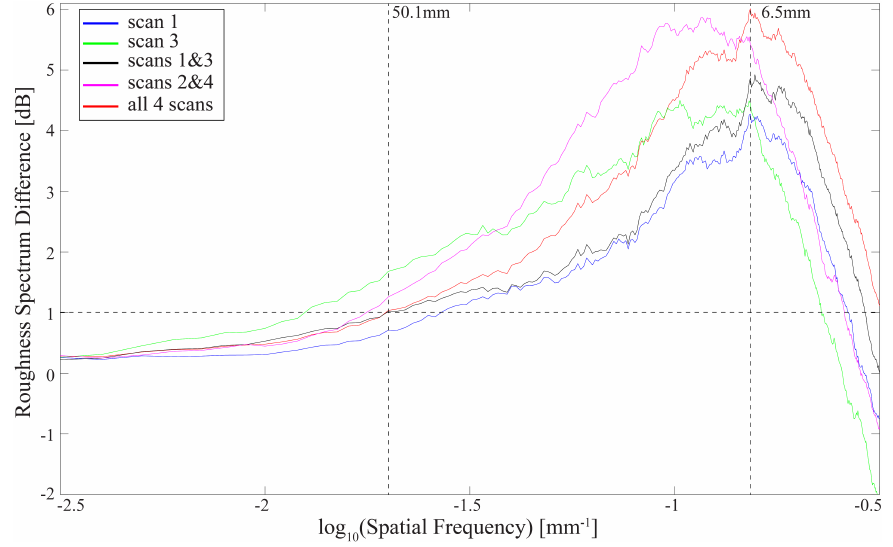
Figure 9. Relative difference of the five TLS roughness spectra with respect to the OTS roughness